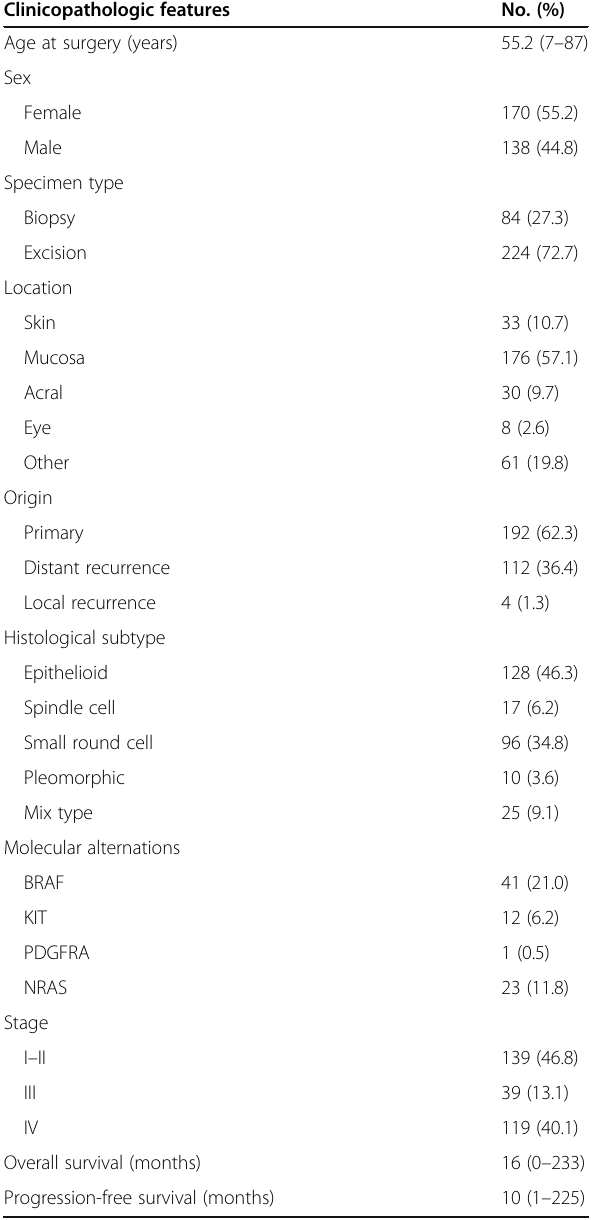
Table 1 Clinicopathological features of 308 patients